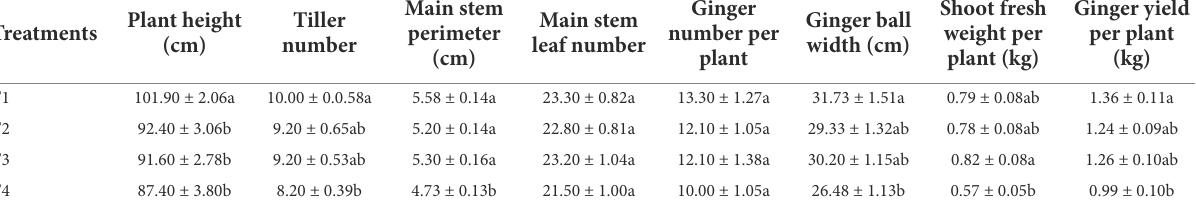
TABLE 1 The growth indices of ginger at harvest stage. Plant height Treatments (cm)